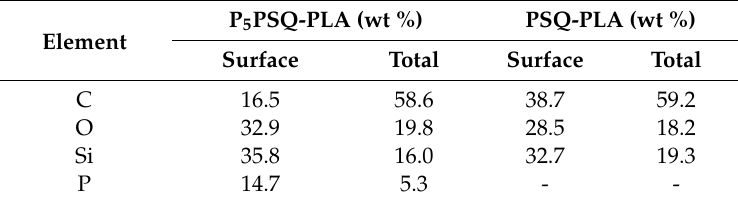
Table 3. Surface and total element content of char residual of P 5 PSQ-PLA. Element